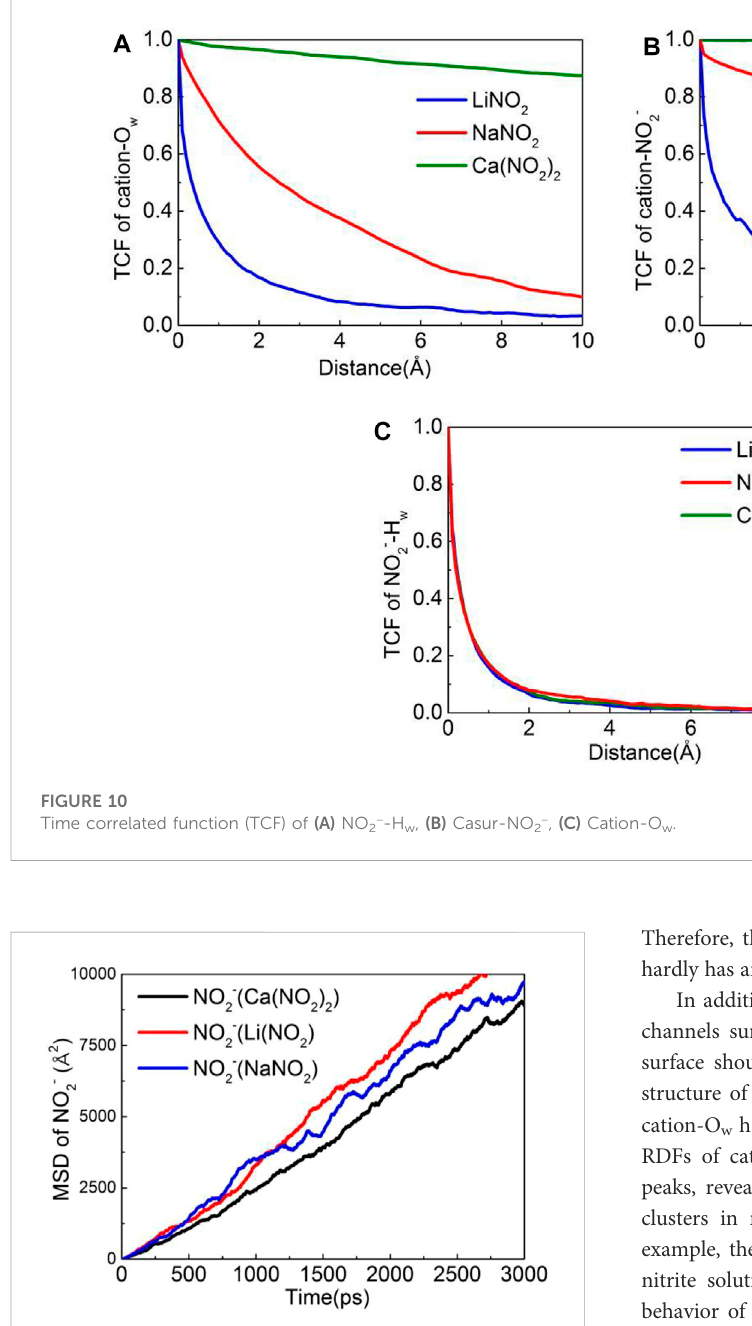
FIGURE 11 MSD of NO 2 − in three kinds of nitrite